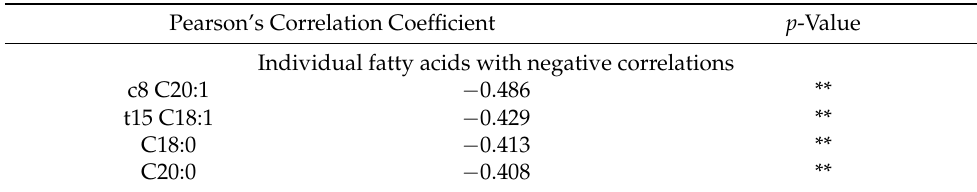
Table 4. Outcome of correlation analysis using fatty-acid profiles (% total) and recorded methane emissions relative to yield (g/kg energy-corrected milk) (showing those with p -values < 0.05). Pearson’s Correlation Coefficient p